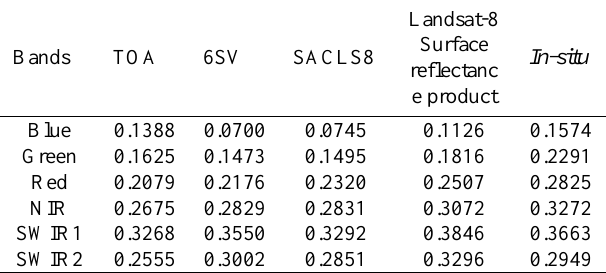
Figure 6: Comparison of SACLS8 surface reflectance with in-situ measurements Table.2: Comparison of surface reflectance derived by different